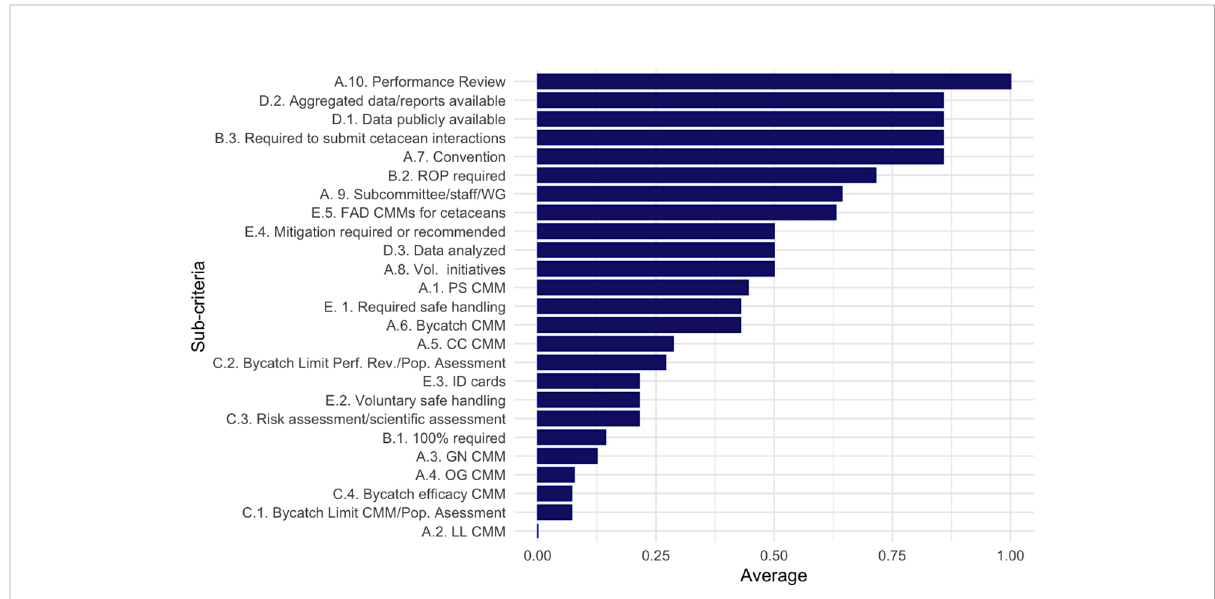
FIGURE 5 The average total score for each sub-criterion for all